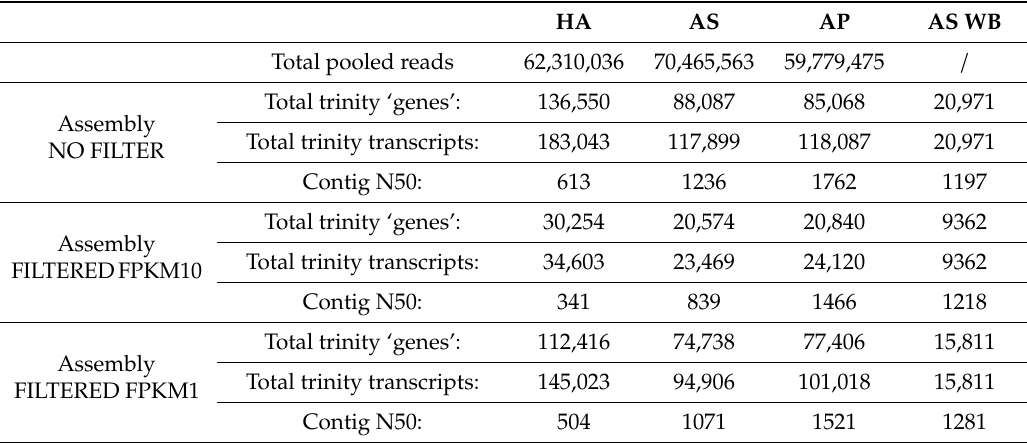
Table 1. RNAseq results.